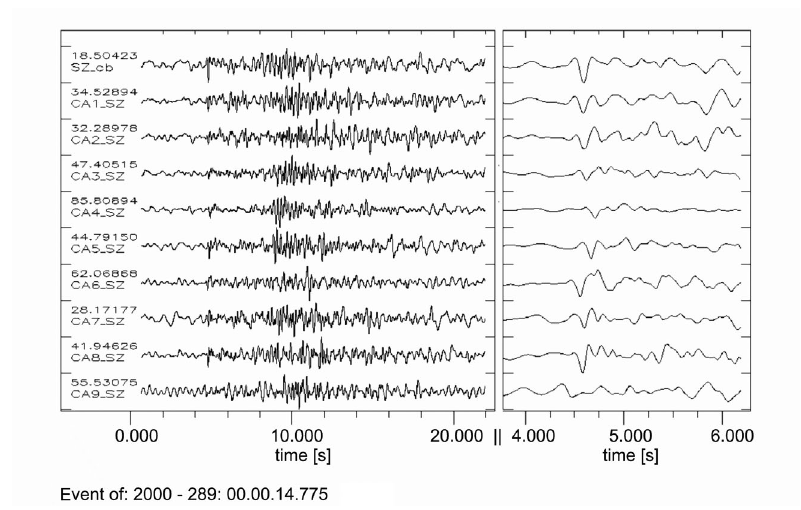
Fig. 4. Vertical seismograms (CA1_SZ-CA9_SZ) and corresponding beam (upper trace SZ_cb), calculated for apparent velocity and backazimuth, determined by the f - k analysis of fig. 5. The right side shows a blow-up for the Pg